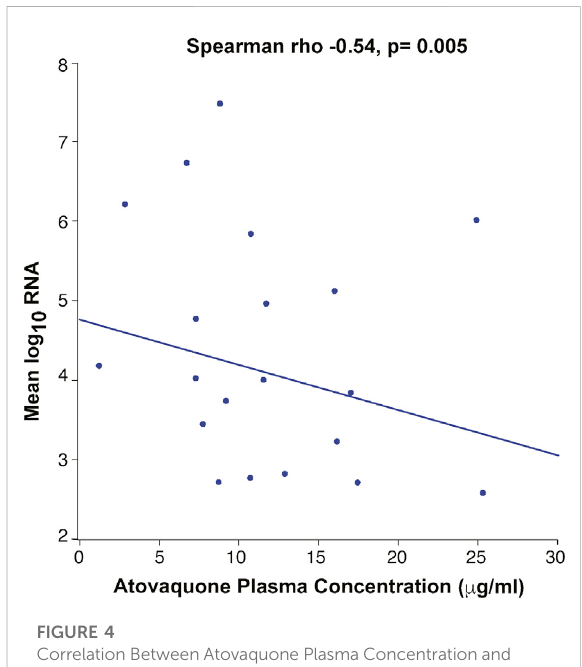
FIGURE 4 Correlation Between Atovaquone Plasma Concentration and Viral Load. Mean log SARS-CoV-2 viral RNA showed an inverse correlation with atovaquone plasma concentration (rho − 0.54, p-